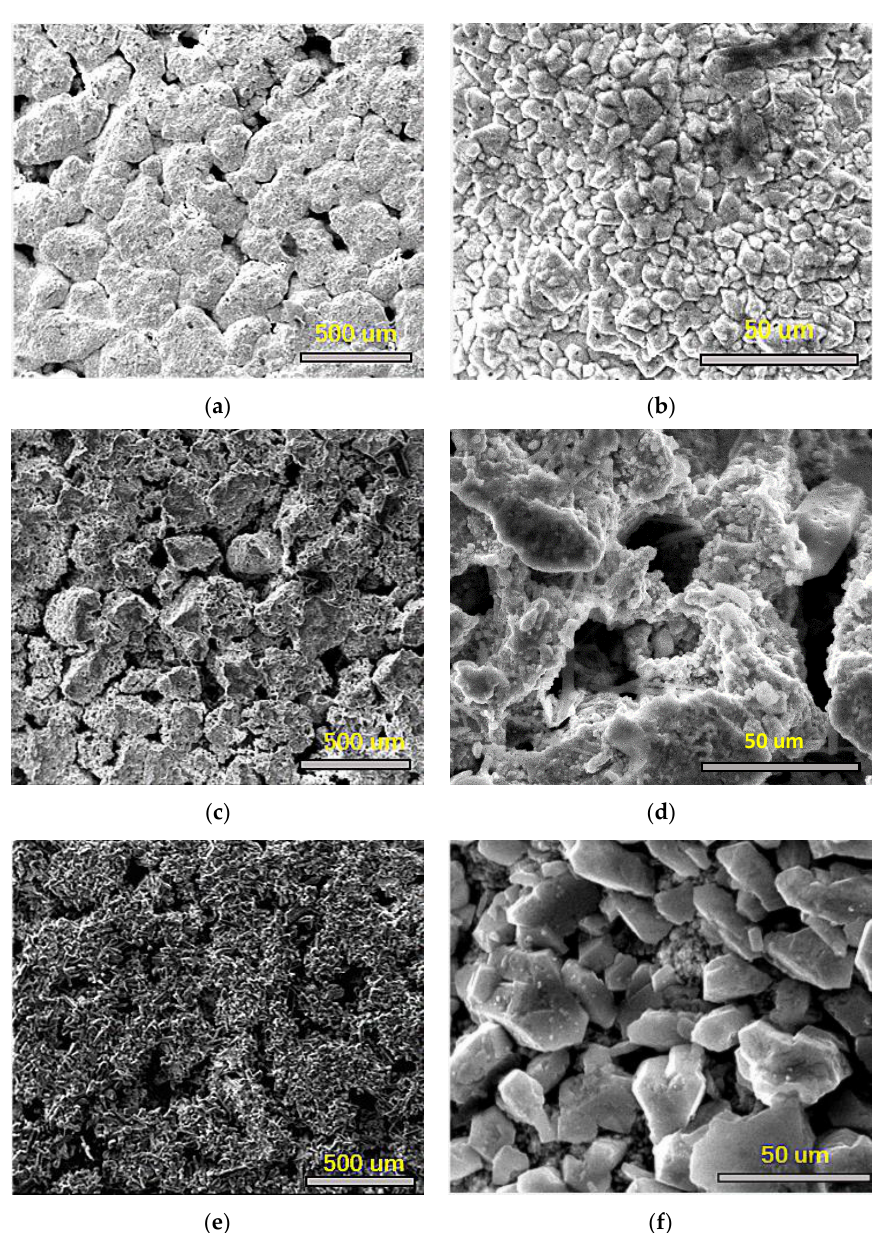
Figure 1. SEM of different electrodes, ( a ) (porous titanium plate,80X); ( b ) (flat Ni-Ce-PbO 2 Figure 1. SEM of di ff erent electrodes, ( a ) (porous titanium plate, 80 × ); ( b ) (flat Ni-Ce-PbO 2 electrode, electrode,1200X) and ( c ) (porous undoped PbO 2 electrode,80X); ( d ) (porous undoped PbO 2 1200 × ) and ( c ) (porous undoped PbO 2 electrode, 80 × ); ( d ) (porous undoped PbO 2 electrode, 1200 × ) electrode,1200X) and ( e ) (porous Ni-Ce-PbO 2 electrode,80X); ( f ) (porous Ni-Ce-PbO 2 electrode, and ( e ) (porous Ni-Ce-PbO 2 electrode, 80 × ); ( f ) (porous Ni-Ce-PbO 2 electrode, 1200 × 1200X).